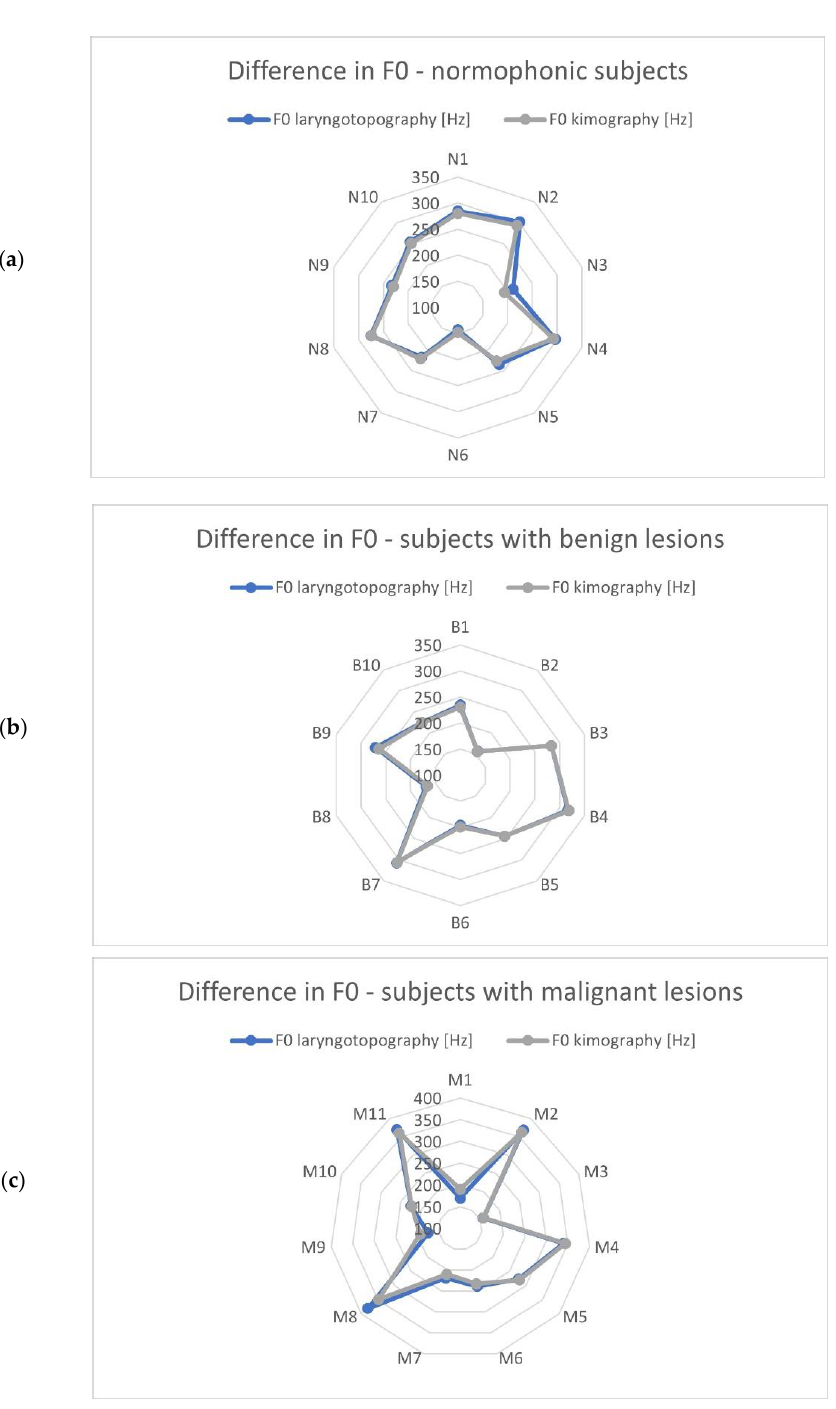
Figure 6. Comparison of the fundamental frequencies obtained from HSV recordings by means of laryngotopography and kymography analyses for each study group: ( a ) normophonic, ( b ) benign, and ( c ) malignant lesions. The scale of the polar diagrams is given in Hz and the codes N1-N10, B-10 and M1-M11 correspond to the normophonic subjects and subjects with benign and malignant lesions, respectively.